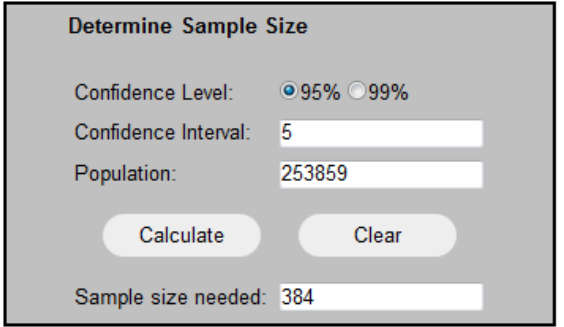
Figure 2. Determination of sample size using the Sample Size Calculator [38].